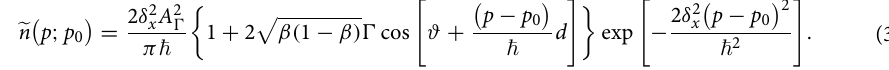
n ( p ) does not depend on ϑ (cid:31)